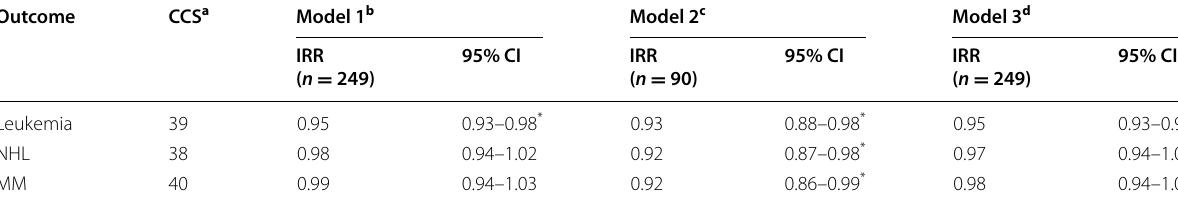
IRR incidence rate ratio, CI confidence interval * P < 0.05; residual deviance exceeds degrees of freedom so robust standard errors were applied using R (packages ggplot2 and sandwich). The fixed-effects approach demands a great number of parameter estimates which did not properly converge in our negative binomial regression, creating the incidental parameter bias and invalidating this option to correct for model overdispersion. The conditional and unconditional Poisson fixed-effects analyses produce identical estimates, however a Using all International Classification of Diseases, Ninth Revision, Clinical Modification (ICD-9-CM) codes included in the Clinical Classification Software (CCS) in HCUP (1997–2007), as described in our prior investigation [3] b Unadjusted model, farm use of nitrogen fertilizers, as described in our prior investigation [3] c Controlling for a 1-year lagged, logged measures of non-farm use of nitrogen fertilizers and pesticides, including atrazine, cypermethrin, dicamba, glyphosate, 2,4-D, and 2-methyl-4-chlorophenoxyacetic acid (MCPA), that are associated with arable agriculture crop production (United States Geological Survey, USGS) high estimates, years: 1996–2006) [3] d Removing cypermethrin and MCPA data due to